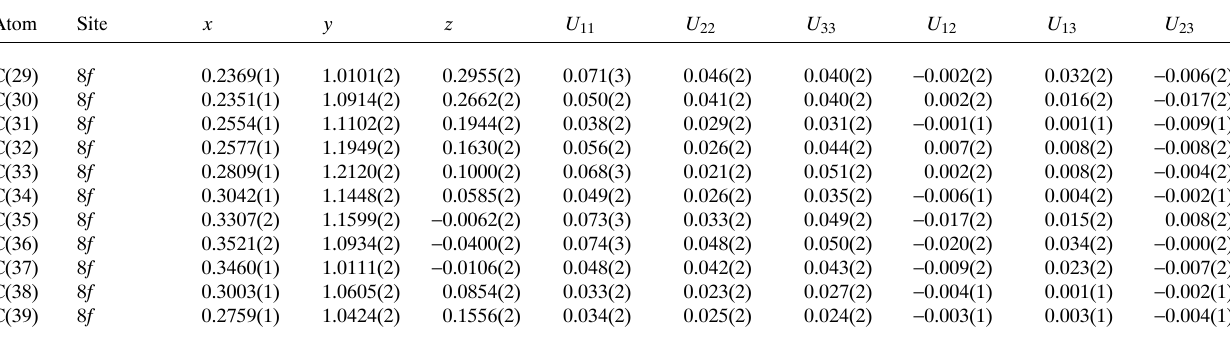
Table 3. C ontinued